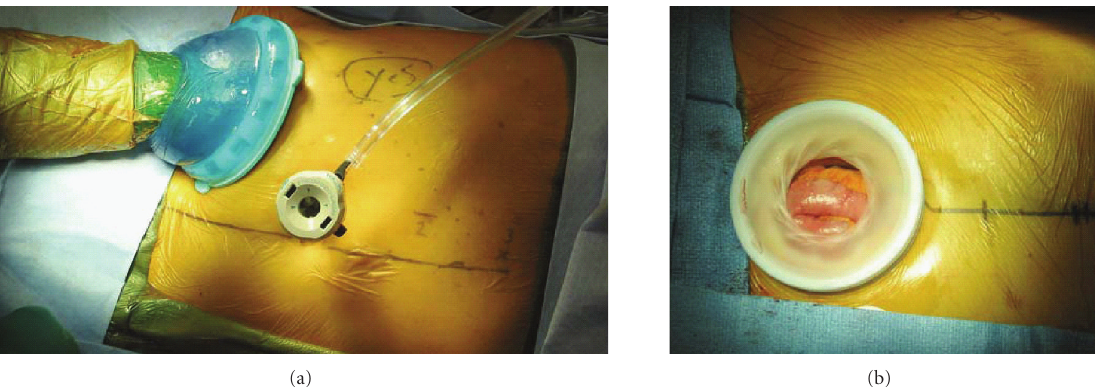
Figure 3: (a) Right lower quadrant hand-port placement for hand-assisted right radical nephrectomy, and (b) Lower midline hand-port placement for hand-assisted right radical